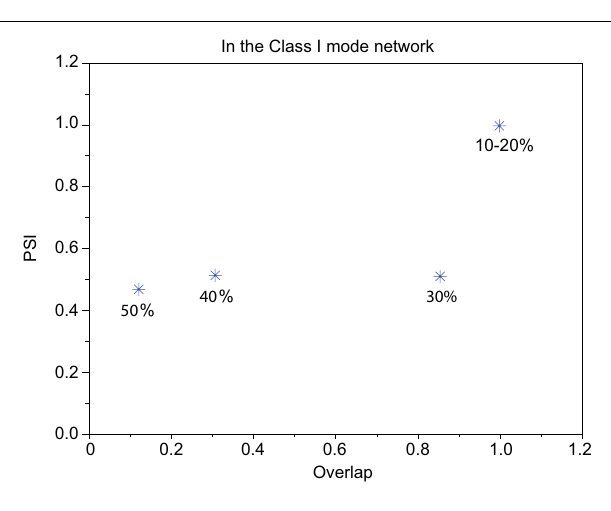
FIGURE 11 | Relevance of the overlap and the synchronization in Figure 10.